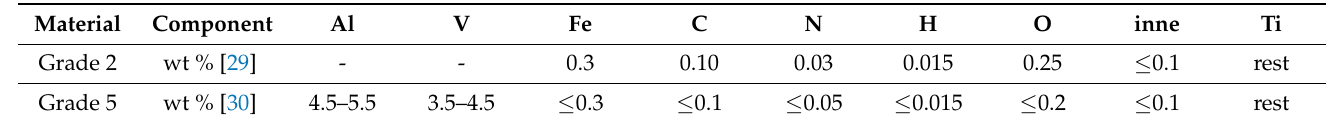
Table 3. Chemical composition of technically pure titanium (Grade 2) and Ti6Al4V titanium alloy (wt